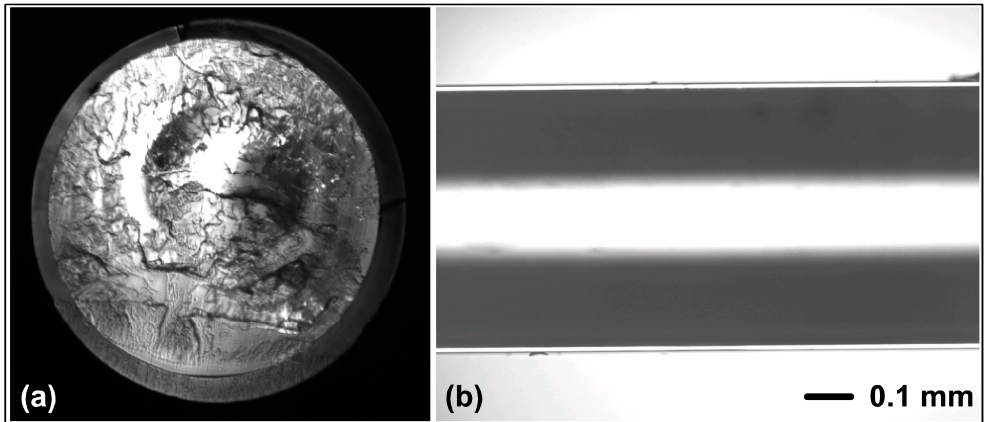
Figure 6. Copolymeric MMA- co -IBMA (33.4 mol %) POF end face ( a ) and side view under a light microscope with 5 × magnification ( b ).